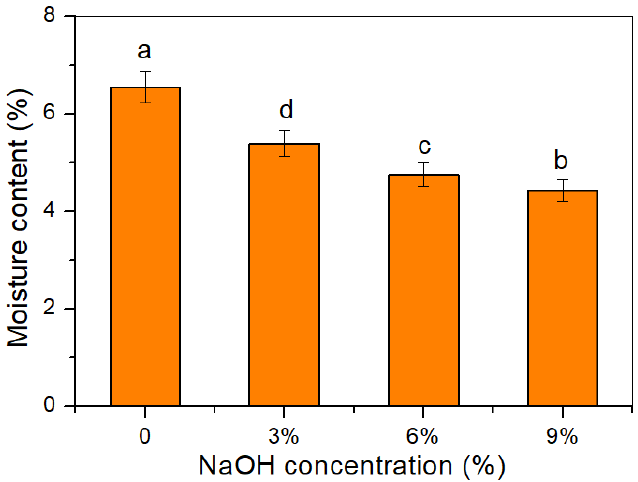
Figure 9. Moisture content of untreated and treated TPCS/PW/CCF composites. Letters a, b, c and d is indicates the group of data for statistical analysis.